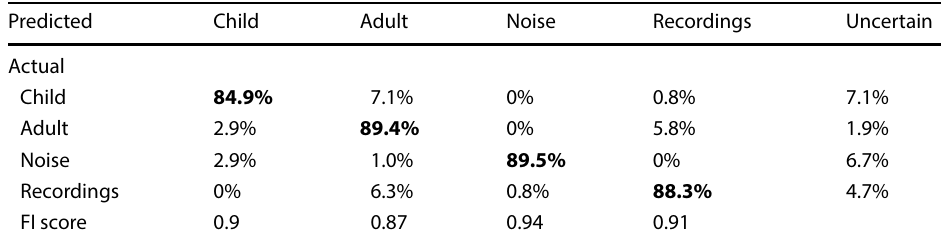
Best performing methods are shown in